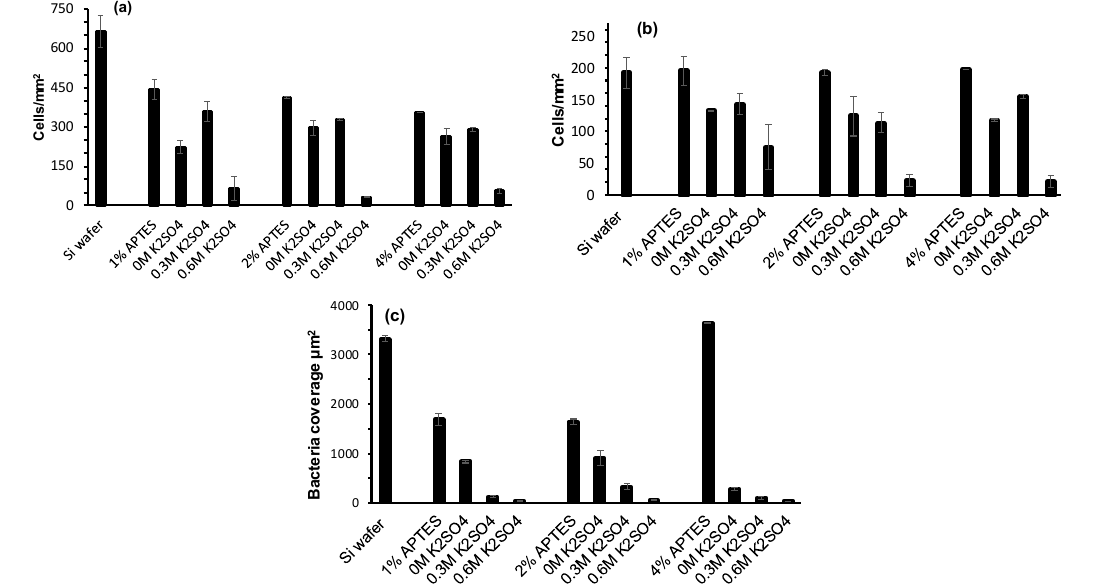
Figure 6. ( a ) Human mesenchymal stem cell, ( b ) MG63 osteoblast-like cell, and ( c ) P. aeruginosa attachment to Si wafers, APTES and PEG surface grafted under different conditions. Polymers 2017 , 9 , 343